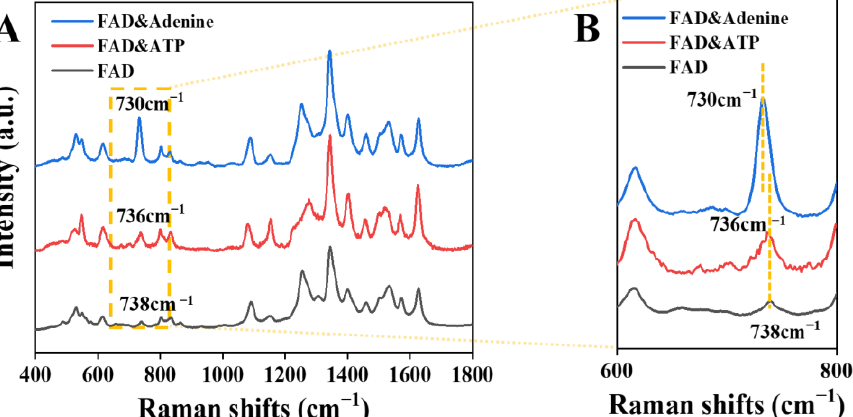
Figure 5. ( A ) The 532-nanometer laser Raman spectra of the FAD mixed with the same concentra- tion of a denine or ATP. ( B ) The magnified spectra of the yellow dotted line area of spectra A.